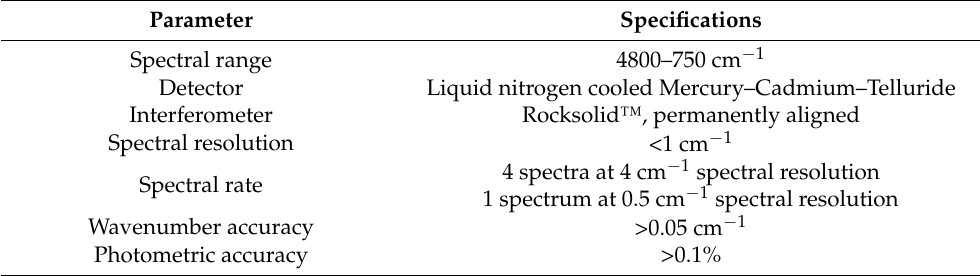
Table 5. Specifications of FTIR emission analyzer (Bruker Matrix MG5).